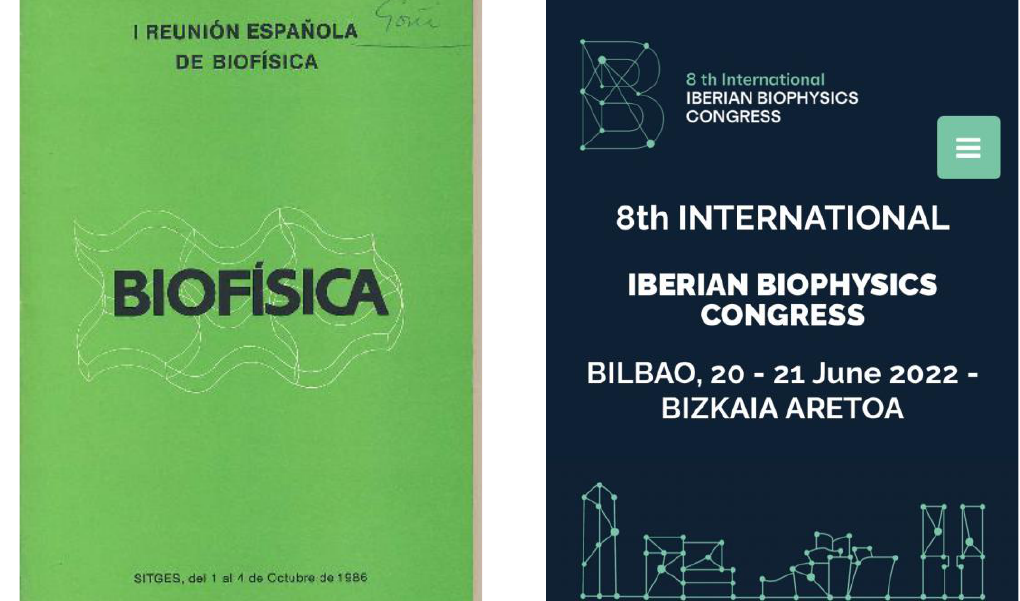
Figure 1. The 1986 and 2022 announcing posters of the Sitges and Bilbao meetings.